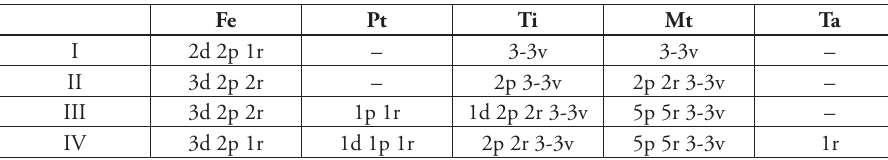
Female: Total length 9.75. Carapace 5.00 long, 4.00 wide. Abdomen 4.75 long, 3.50 wide. Eye sizes and interdistances: AME 0.25, ALE 0.20, PME 0.25, PLE 0.20; AME-AME 0.10, AME-ALE 0.10, PME-PME 0.20, PME-PLE 0.25. Leg measure- ments: I: 14.00 (4.50, 4.75, 3.25, 1.50); II: 13.20 (4.20, 4.50, 3.00, 1.50); III: 12.05 (4.00, 4.00, 2.80, 1.25); IV: 14.50 (4.75, 4.75, 3.50, 1.50). Carapace yellow.